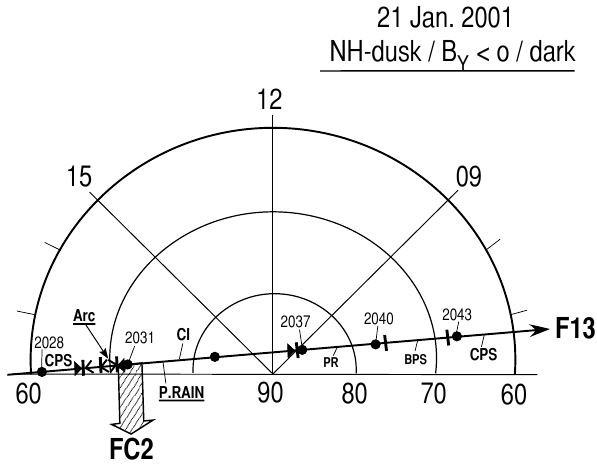
Fig. 19. DMSP F13 track across the polar cap in the Northern Hemi- sphere. The event category is: NH-dusk/ B y < 0 (dark). Polar rain precipitation, flow channel FC 2, and the arc on its equatorward boundary have been marked. C1 represents Birkeland current in the P.RAIN